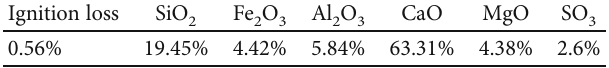
Table 2: Measured rheological properties and density of the tested